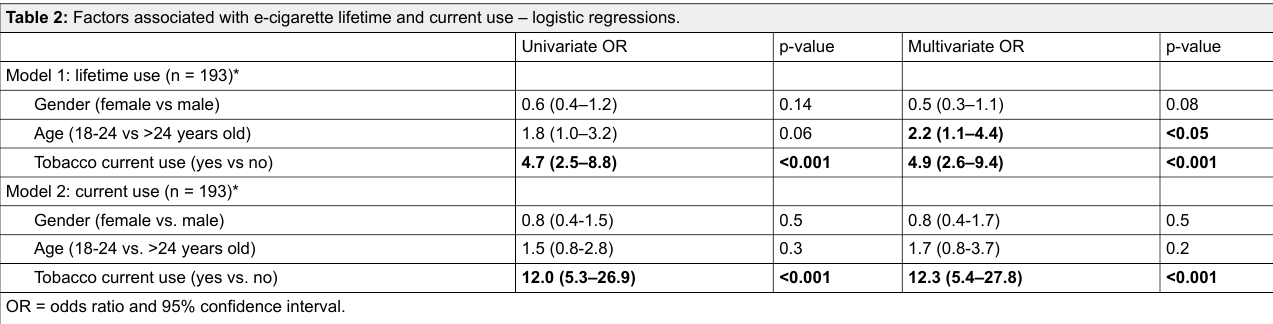
Table 2: Factors associated with e-cigarette lifetime and current use – logistic